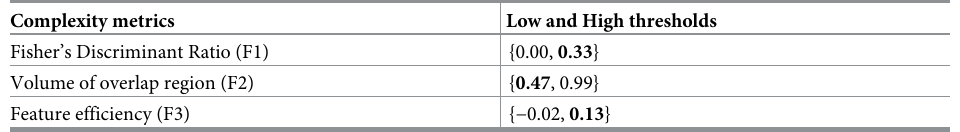
Table 2. Thresholds for single feature